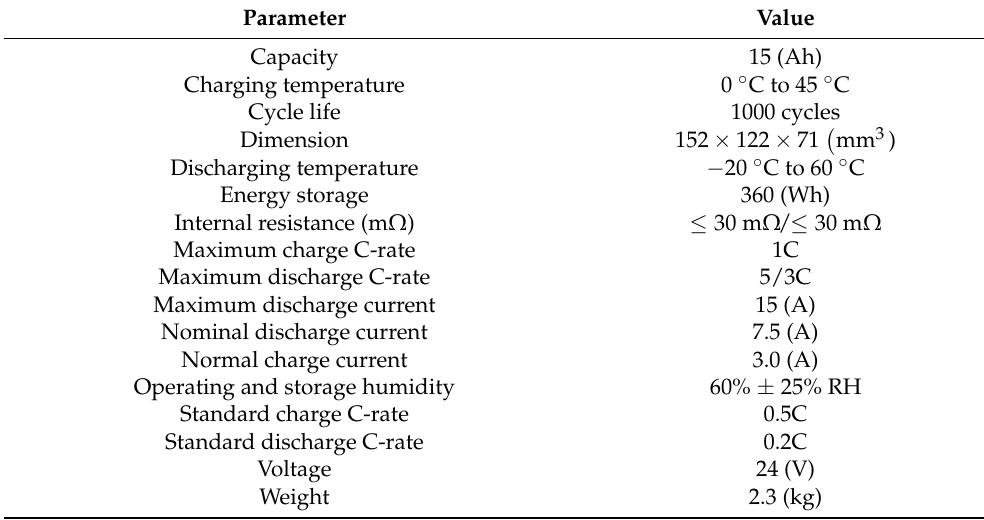
Table 1. The specification of the utilized NMC battery in the suggested integrated system for the